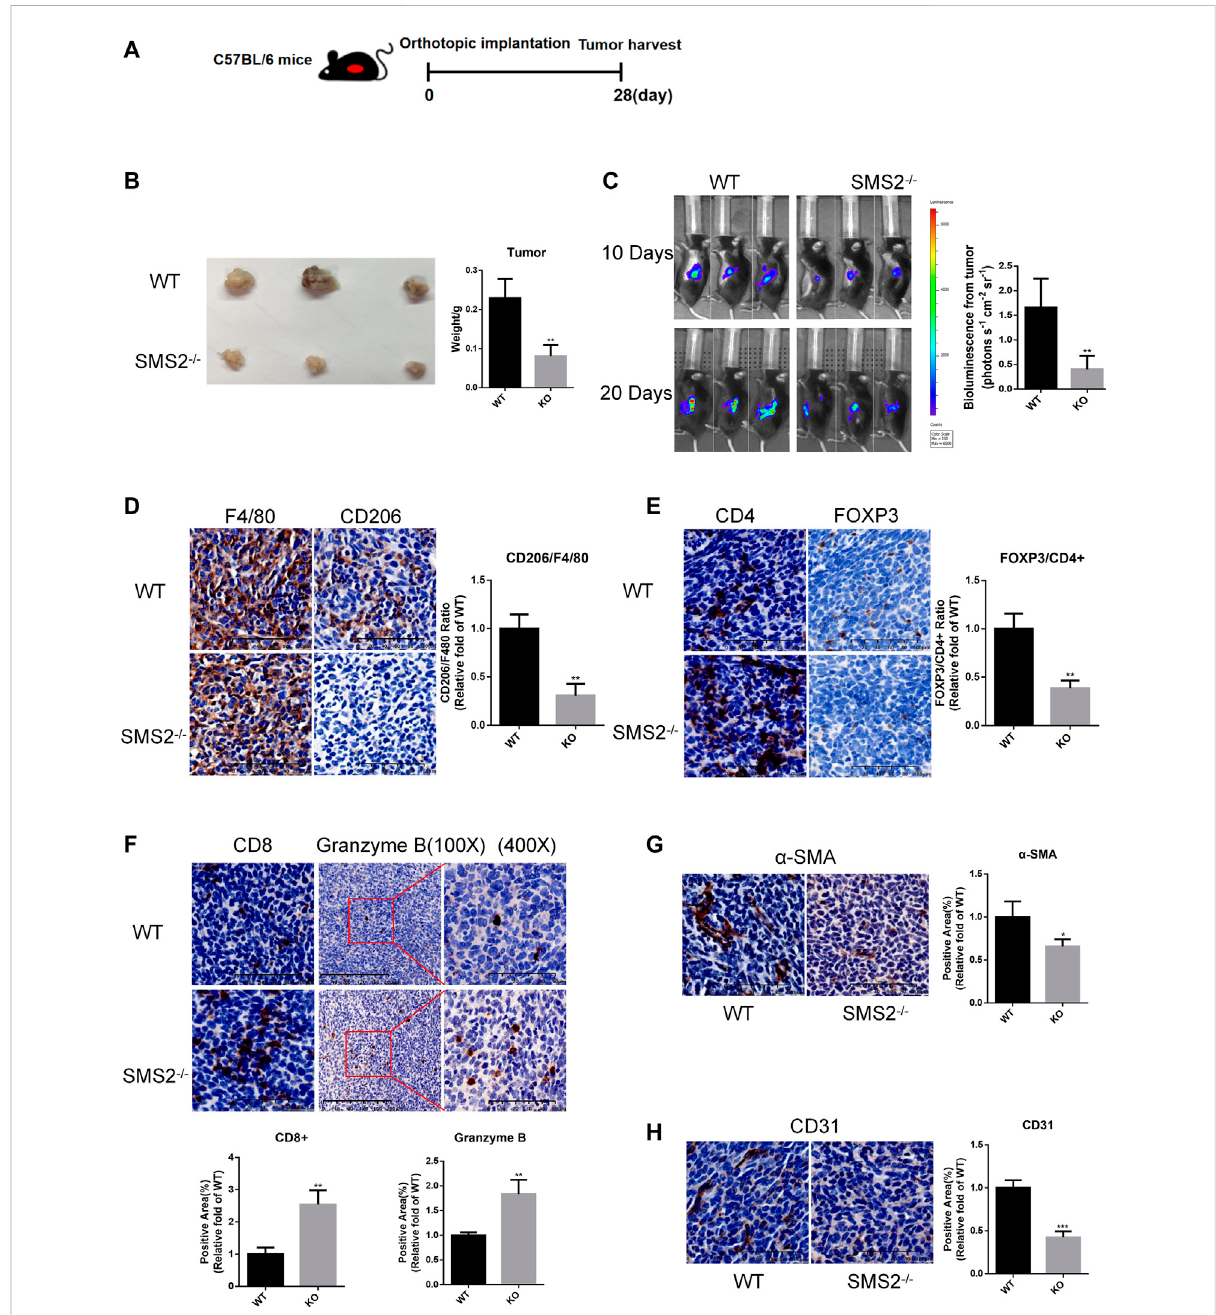
FIGURE 2 SMS2 knockout can inhibit the growth of PANC-02 orthotopic pancreatic tumor in vivo . (A) . Construction of orthotopic pancreatic tumor model of gene knockout mice. (B) . Tumor tissue harvested after 28 days. (C) . Representative bioluminescence images at10th day and 20th day after tumor inoculation and quantitative analysis at 20th day. (D) . IHC representative images of M2 macrophages in tumor tissues and quanti fi cation. IHC representative images and quanti fi cation of immune cells CD4, FOXP3/CD4 (E) , CD8, Granzyme B (F) , CAF ( α -SMA) (G) and vascular in fi ltration (CD31) (H) intumortissues.Theresultsareshownasthemean±SD.* p < 0.05;** p < 0.01;*** p < 0.001(n=5mice/group).Theobserved fi eldis200X zoom of original IHC